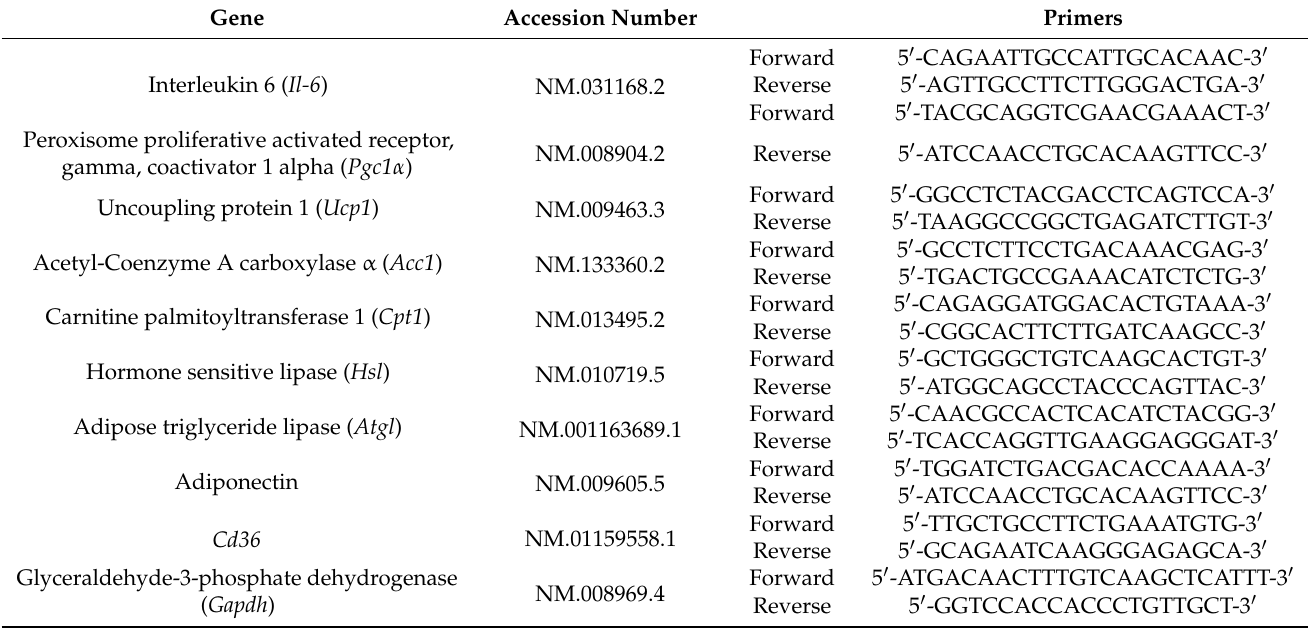
Table 1. Sequences of primers used for quantitative real-time